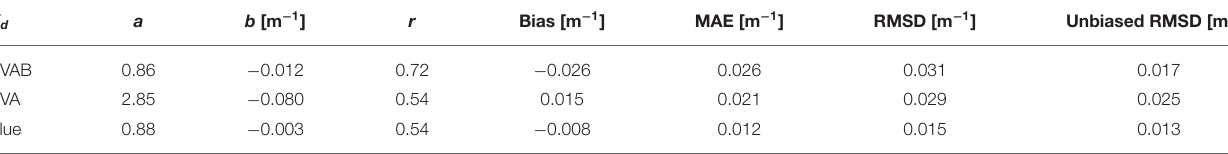
Given are slope a and intercept b from linear least-square regression, Pearson correlation coefficient r, bias, mean absolute error (MAE), and root mean square difference (RMSD).